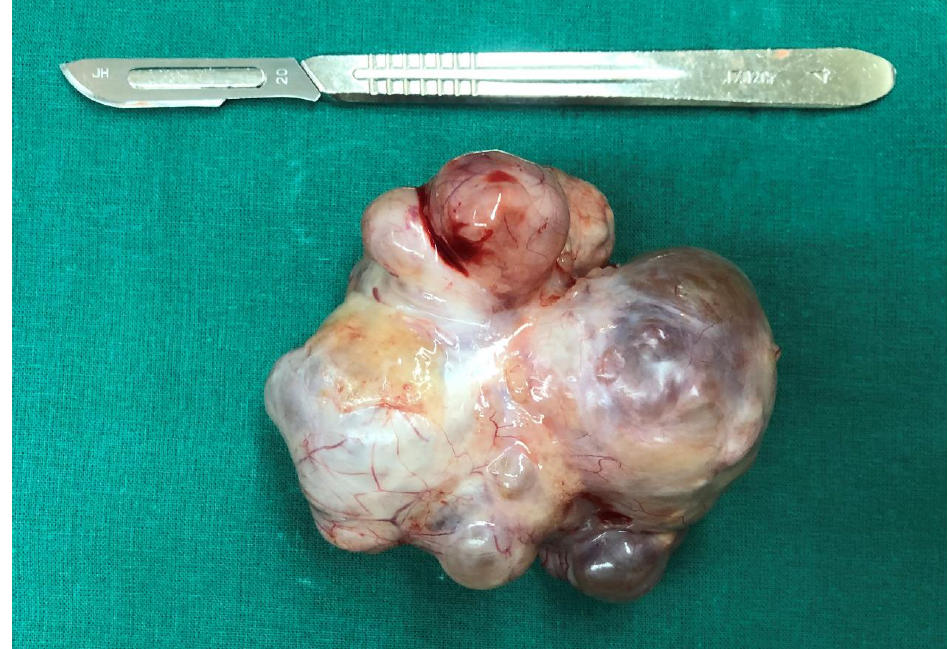
Figure 5. The tumor showed a smooth and irregularly lobulated gross appearance.